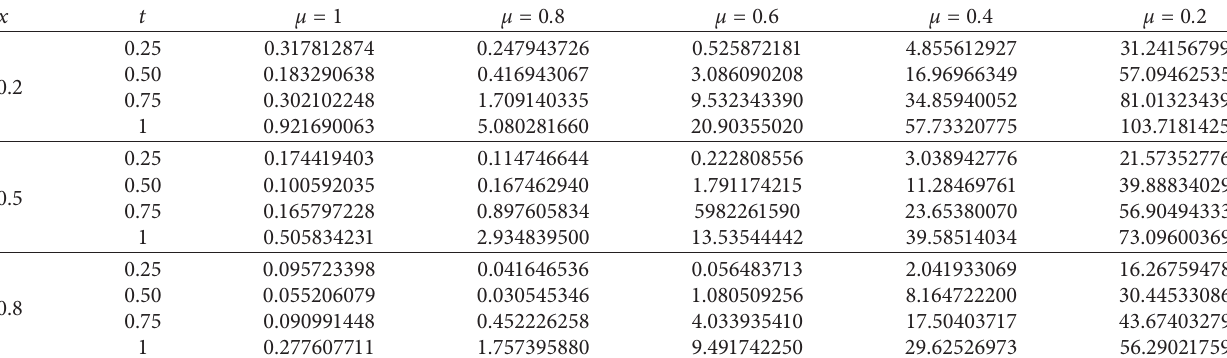
Table 6: The numerical value for v (x, t) of equation (62) for different values of x and t